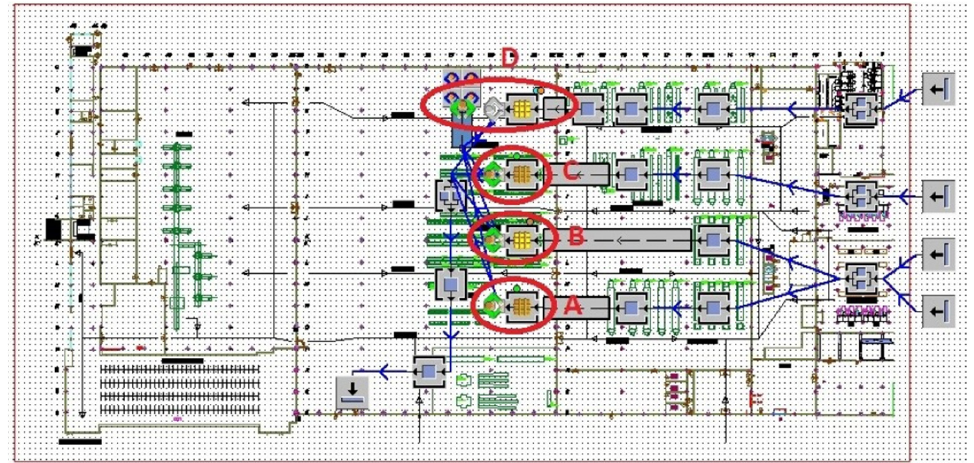
Figure 9. Course of the simulation after the changes in the layout of workplaces.